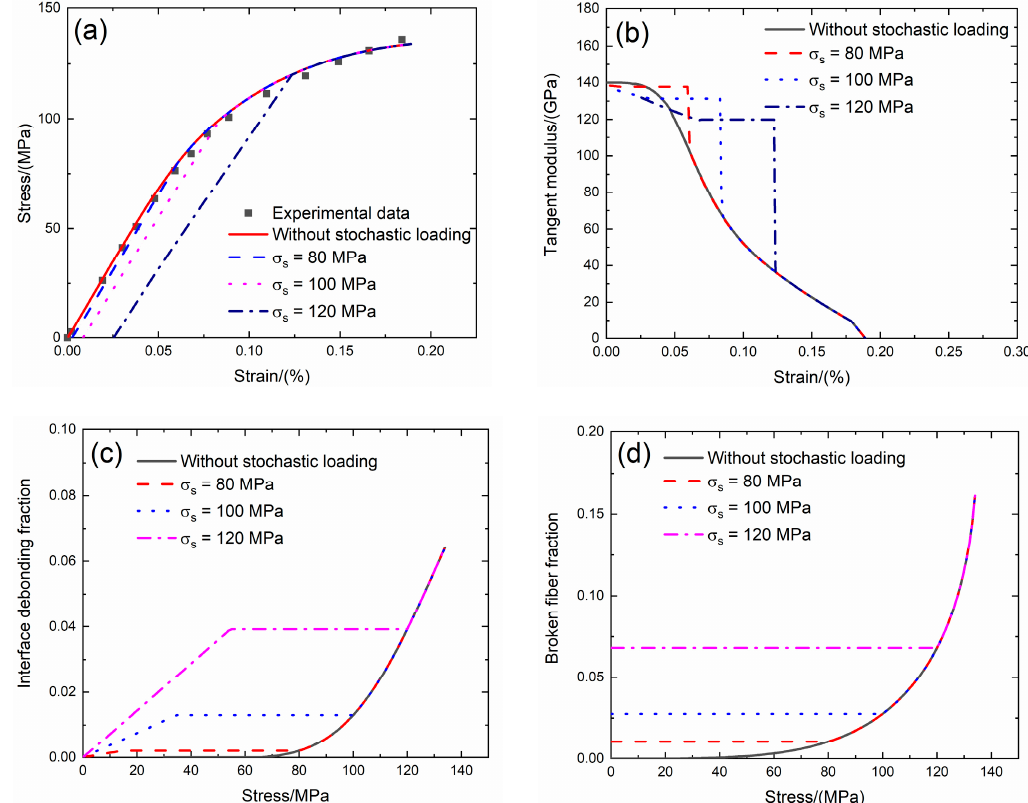
Figure 15. ( a ) The tensile stress–strain curves; ( b ) the tangent modulus versus strain curves; ( c ) the interface debonding fraction versus stress curves; and ( d ) the broken fibers fraction versus stress curves of 2D SiC/SiC composite for conditions without stochastic loading and with stochastic loading of σ s = 80, 100 and 120 MPa. Table 8. The tensile stress–strain curve, tangent modulus, interface debonding fraction and broken fiber fraction of 2D SiC/SiC composite subjected to stochastic loading of σ s = 80, 100 and 120 MPa.